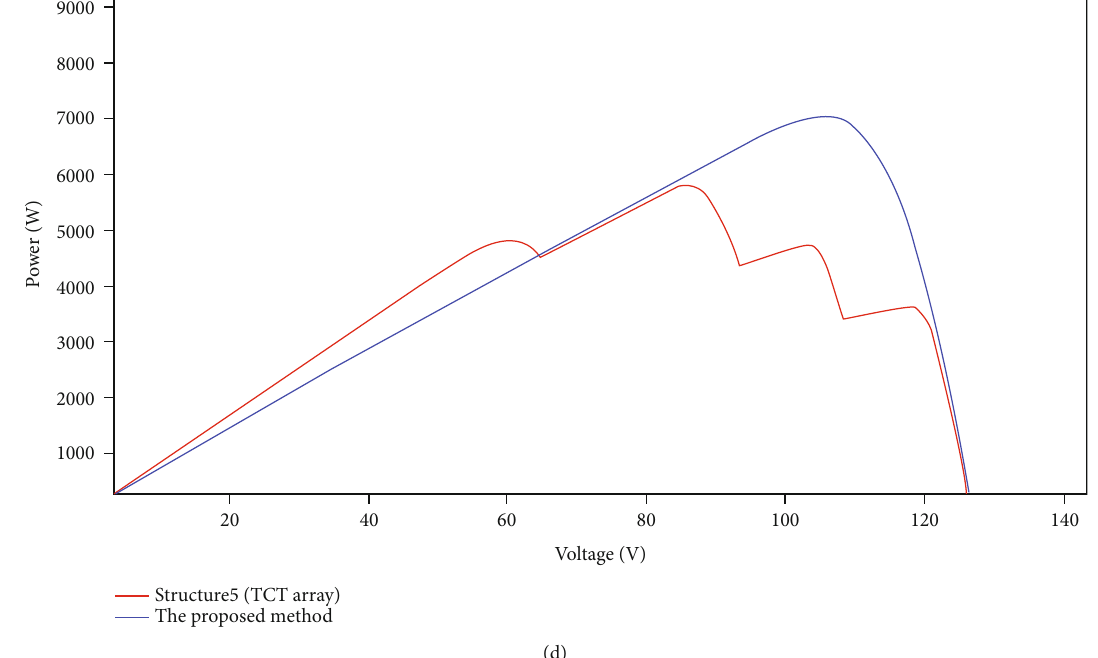
Figure 14: Fifth shading pattern. (a) TCT array. (b) The proposed method before recon fi guration. (c) The proposed method after recon fi guration. (d) The PV array characteristics for the TCT array and the proposed